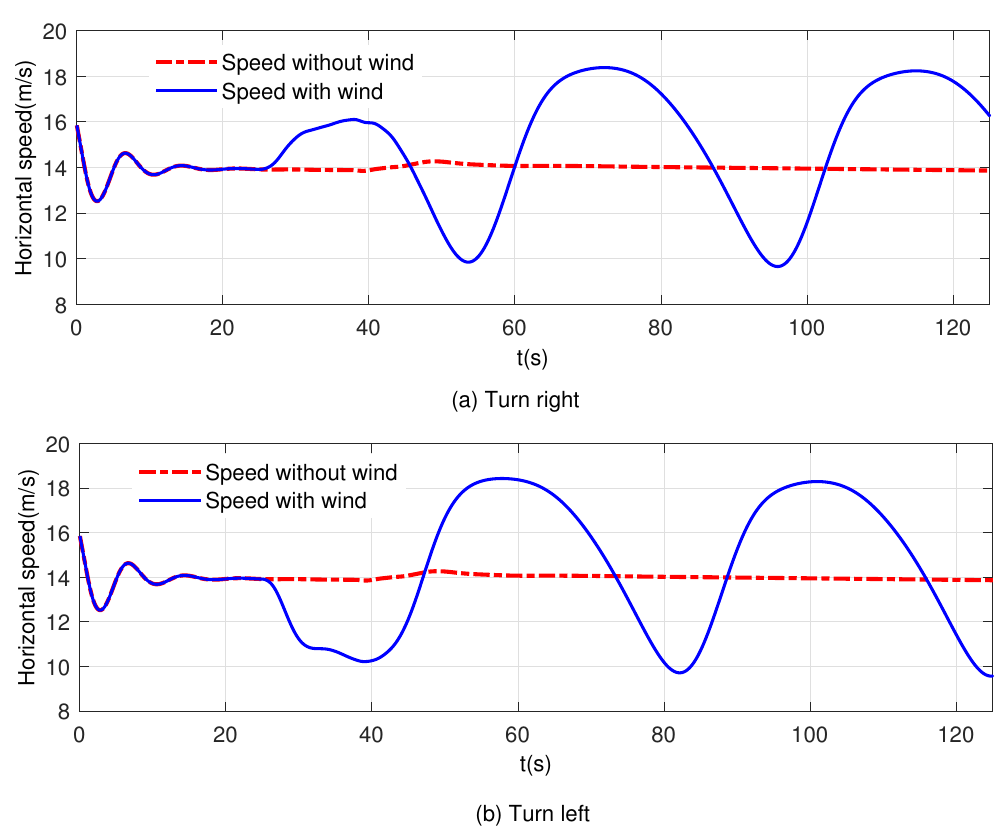
Figure 6. Speeds of the parafoil system before and after adding crosswind. ( a ) Turn right. ( b ) Turn